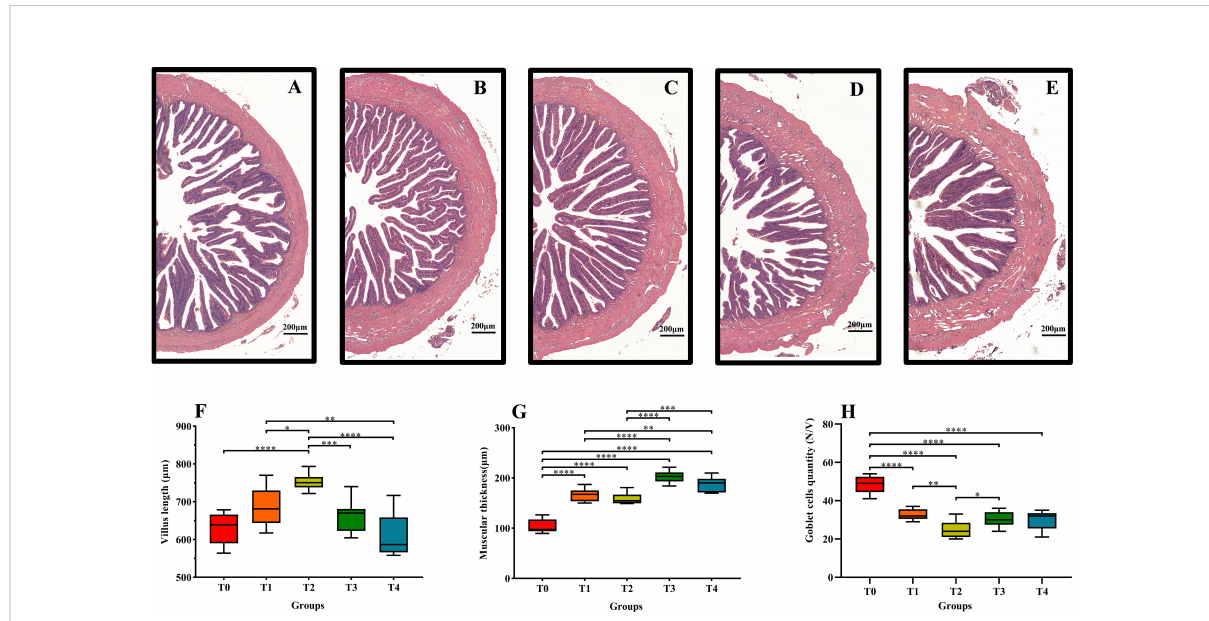
FIGURE 6 Effects of dietary taurine on mid-gut morphology of T. ovatus . (A) : 0% taurine; (B) : 0.40% taurine; (C) : 0.80% taurine; (D) : 1.20% taurine; (E) : 1.60% taurine. Scale bar: 200 m m. The villus length (F) , muscular thickness (G) , and goblet cells quantity (H) of mid-gut in T. ovatus. data are presented as mean ± SD (n = 9).Asterisks *, **, ***,and **** indicate statistically signi fi cant difference between treated group and control group at P < 0.05, P < 0.01 P < 0.001, and P < 0.0001, respectively.